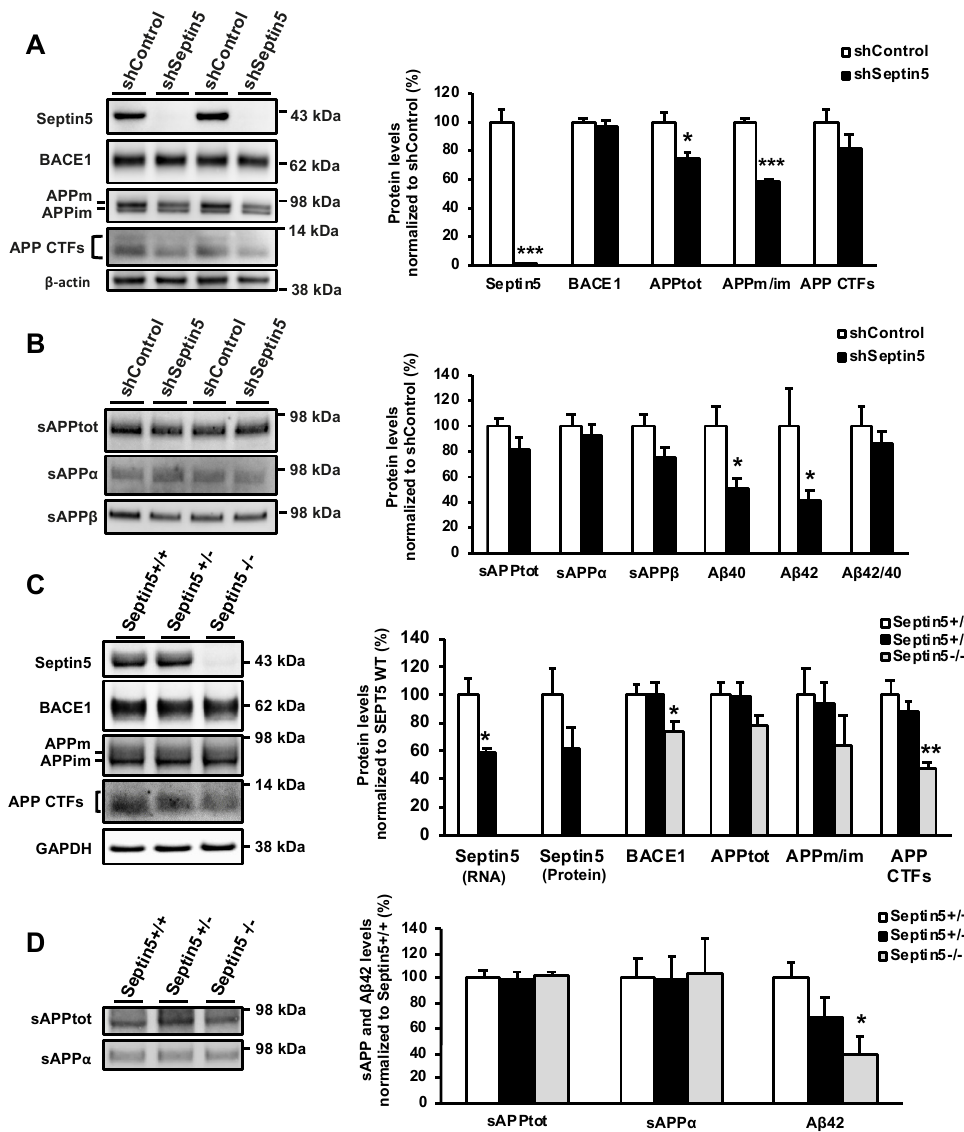
Figure 2. Downregulation of SEPTIN5 affects APP processing and the levels of A β in primary mouse cortical neurons and Septin5 knockout mice. ( A ) Western blot analysis showing a significant downregulation of mouse Septin5 and the ratio of APPm/im in mouse primary cortical neurons transduced with lentiviral Septin5 shRNA; ( B ) A β 40 and A β 42 levels (ELISA) are significantly decreased in mouse primary cortical neurons after the downregulation of Septin5 as compared with the control-transduced neurons. n = 4; ( C ) Western blot analysis of ventral cortical protein lysates from five-month-old Septin5 +/+ , Septin5 +/ − , Septin5 − / − mice. The levels of BACE1 and APP CTFs were significantly reduced in Septin5 − / − mice. Septin5 +/+ ( n = 5), Septin5 +/ − ( n = 5), Septin5 − / − ( n = 4); ( D ) Analysis of sAPPtot, sAPP α , and A β levels in the temporal cortex of Septin5 +/+ , Septin5 +/ − , Septin5 − / − mice. The levels of A β (ELISA) were significantly reduced in Septin5 − / − , but not in Septin5 +/ − mice, suggesting that the effects of Septin5 downregulation on A β were dose dependent. Septin5 +/+ ( n = 7), Septin5 +/ − ( n = 7), Septin5 − / − ( n = 3). In (A, C) protein levels were normalized to β -actin and GAPDH, respectively, and are shown as a % of siControl/Septin5 +/+ , mean ± SEM. In (B) and (D), protein levels were normalized to total protein levels in the respective cell lysates and are shown as a % of siControl/Septin5 +/+ , mean ± SEM. A/B, independent t-test. * p < 0.05, ** p < 0.01, *** p < 0.001. C/D, one-way ANOVA post hoc LSD. * p < 0.05 and ** p < 0.01. 3.2. Downregulation of SEPTIN5 Increases the Degradation of APP CTFs in Neuronal Cells